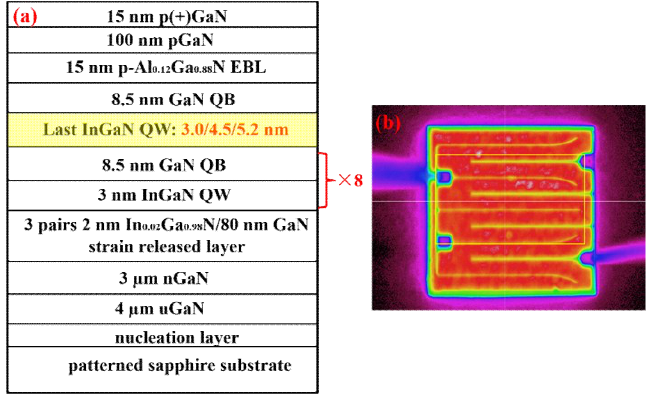
Figure 1. ( a ) Schematic epitaxial structure and ( b ) electroluminescent intensity mapping of the InGaN LED chip (1 mm 2